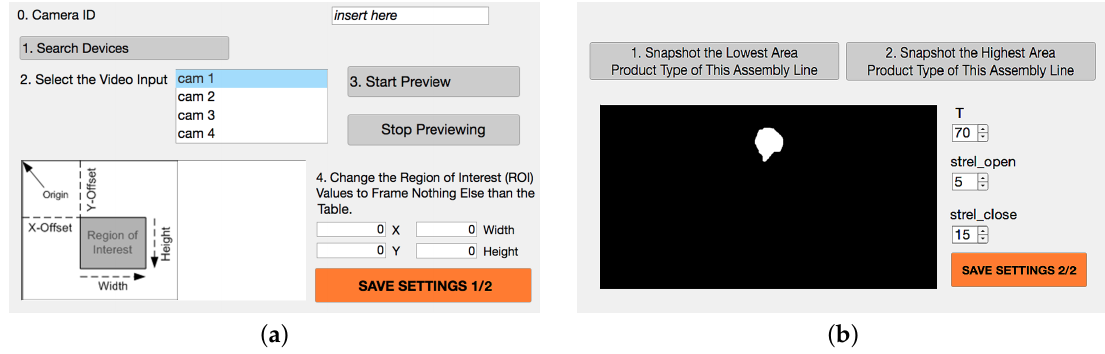
Figure 10. In panel ( a ), we show the first GUI of the parameter Setting Tool App and, in panel ( b ), the second